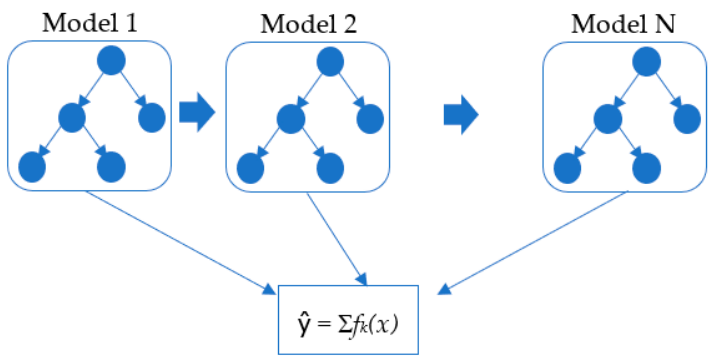
Figure 6. Tree ensemble model for boosting algorithms.